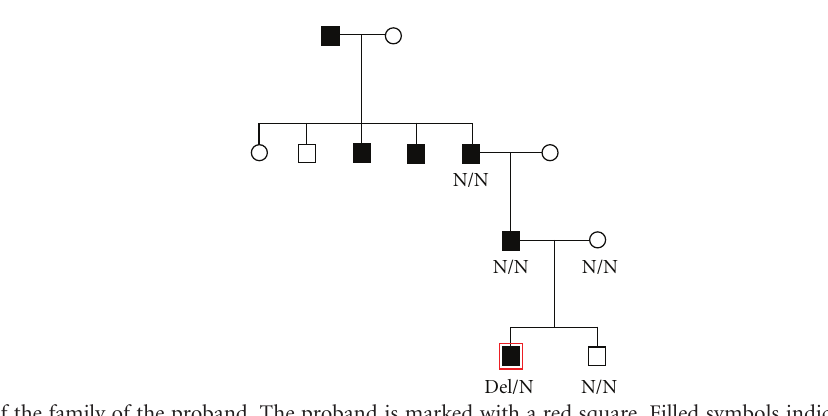
Figure 1: Pedigree of the family of the proband. The proband is marked with a red square. Filled symbols indicate family members with diabetes. The carrier of the GCK deletion mutation is marked with Del/N. Family members tested negative for the GCK deletion are marked with N/N.